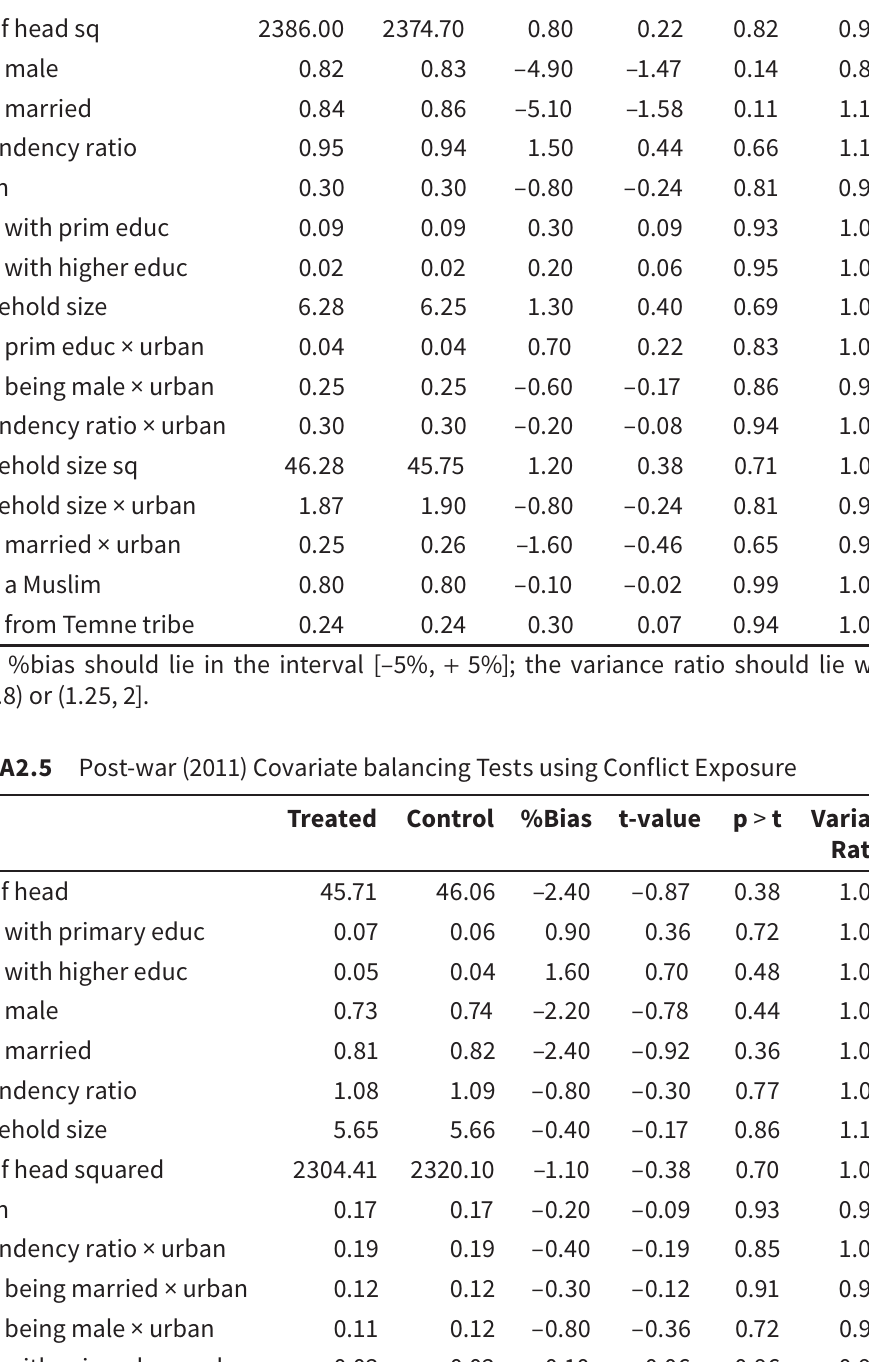
Table A2.4 Post-war (2003) Covariate Balancing Tests using Conflict Exposure Treated Control %Bias t-value p > t Variance Age of head